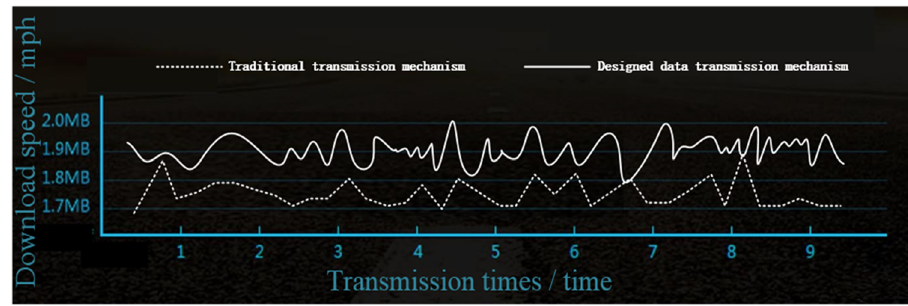
Figure 10: The detection interface of data transmission rate.